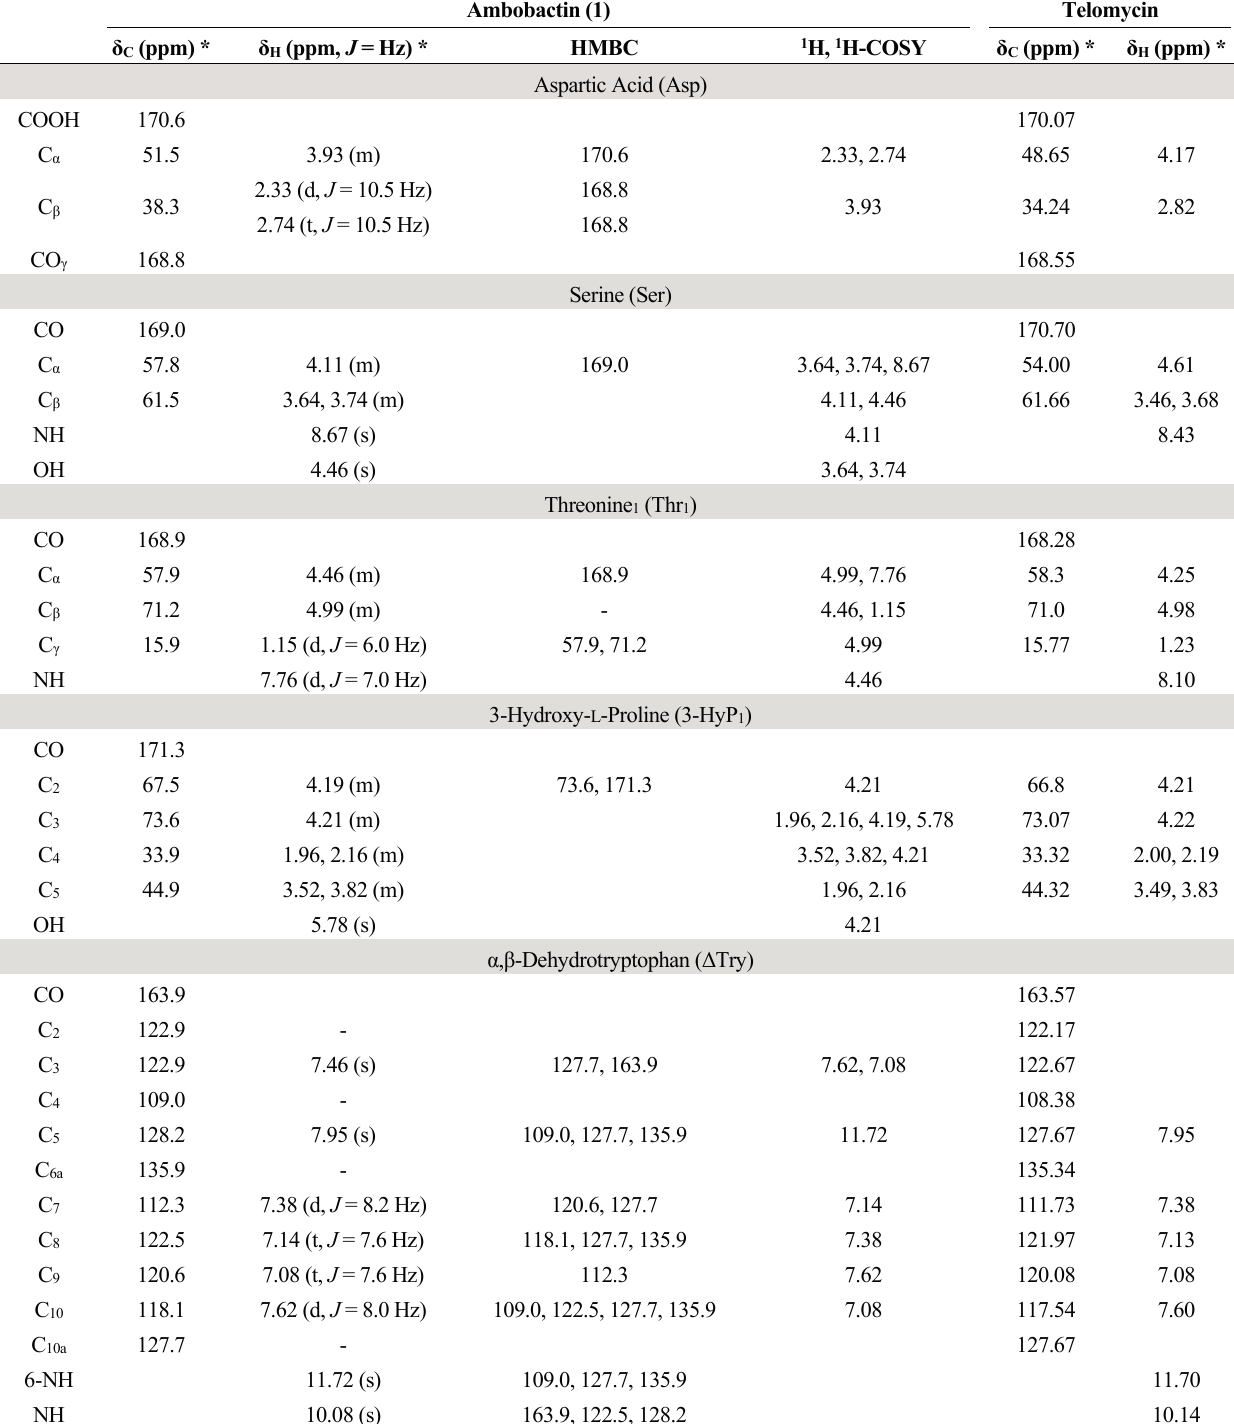
Table 1. NMR data for ambobactin ( 1 ) recorded in DMSO- d 6